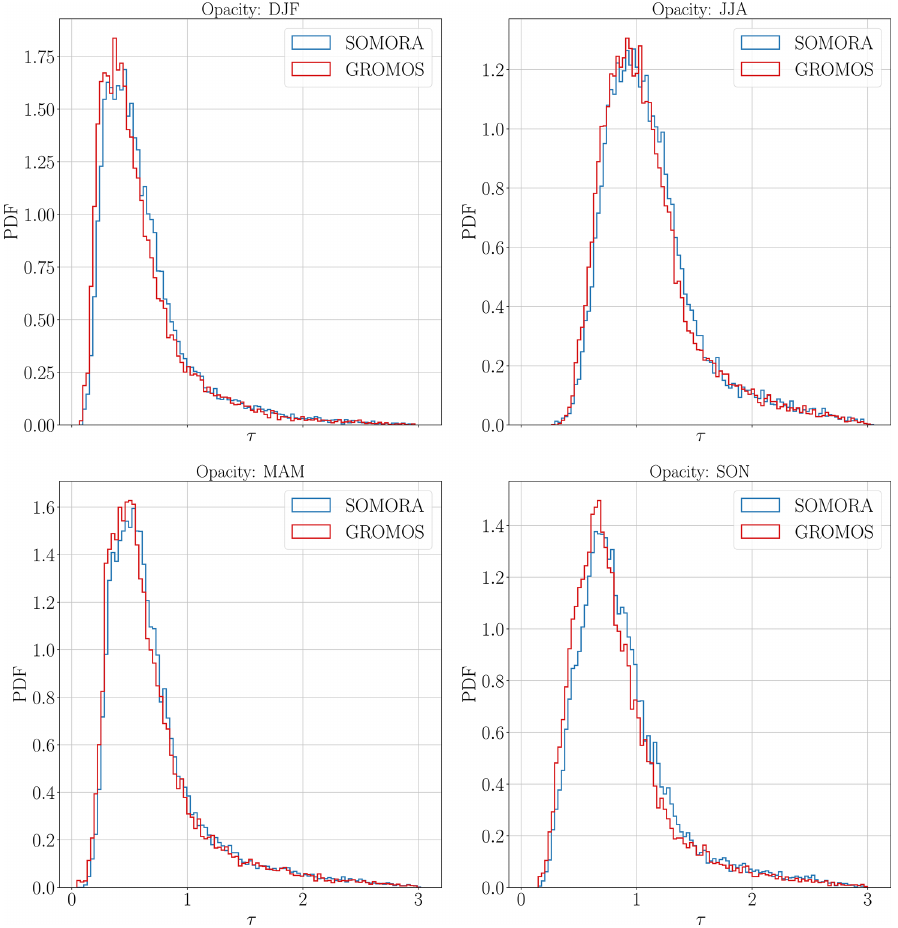
Figure A1. Seasonal comparisons of hourly tropospheric opacities in Bern (GROMOS) and Payerne (SOMORA) from 2009 to